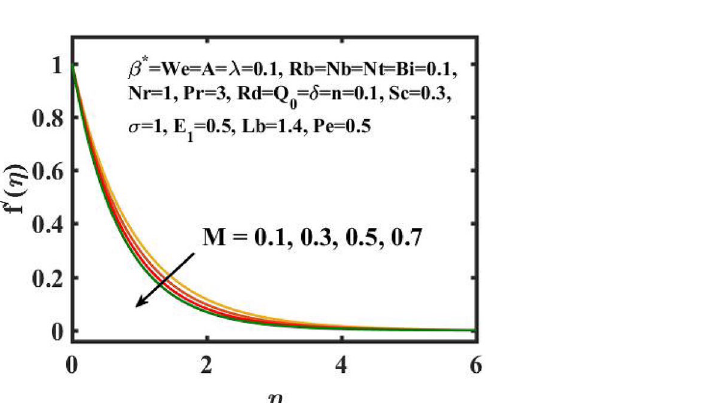
Table 2. Grid independent test for We 0.4, Q 0 N b =